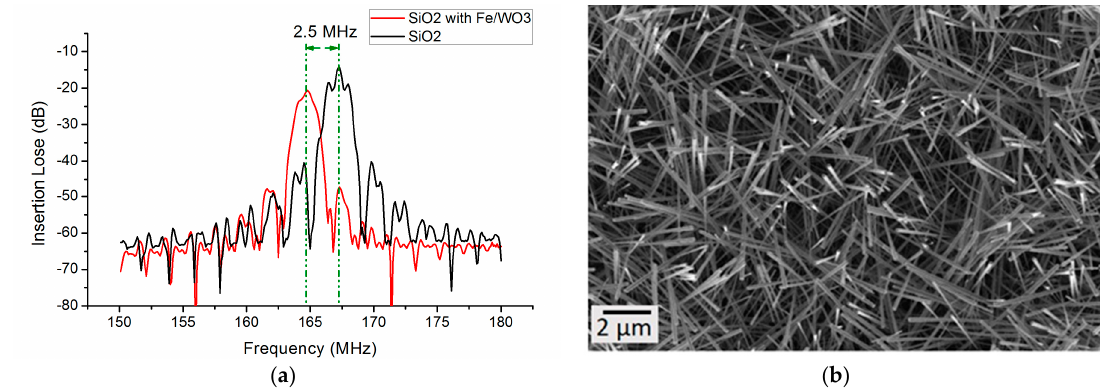
Figure 3. ( a ) Frequency response of the sensor before and after Fe 2 O 3 @WO 3 − x deposition; ( b ) SEM image top view of Fe 2 O 3 @WO 3 − x